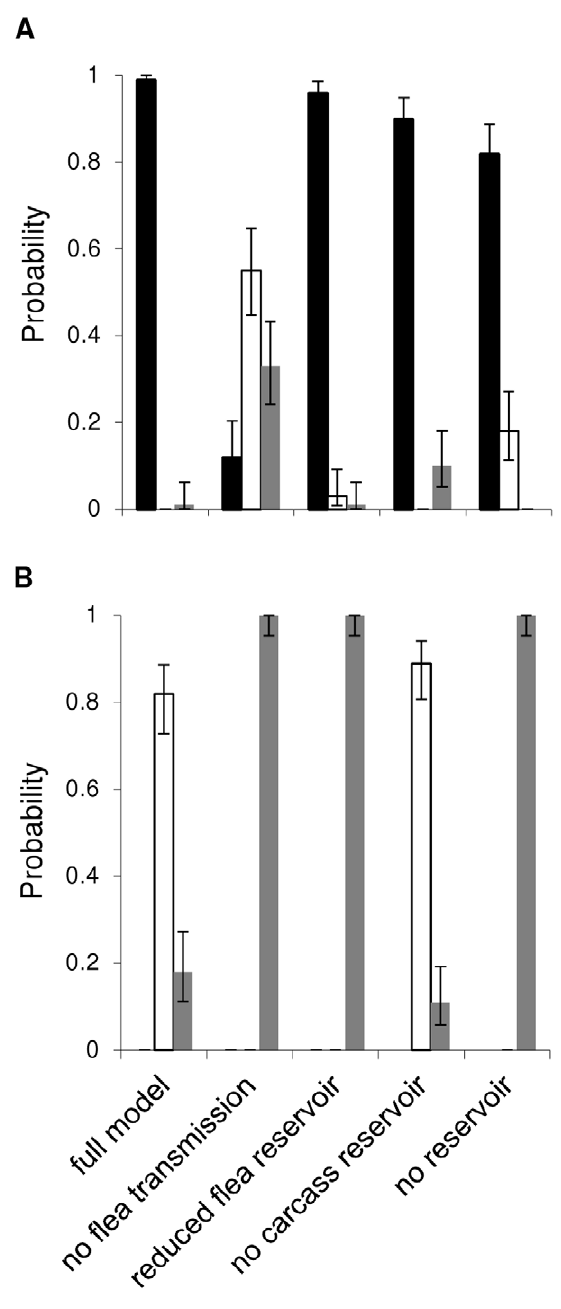
Figure 2. Transmission hypothesis testing. Testing was done using default parameter values for the (a) black-tailed prairie dog and (b) California ground squirrel. Each case represents the effect of removing either one or multiple transmission routes on extinction probability (black bars), enzootic probability (white bars), or disease fade probability (gray bars). 95% confidence intervals are also given.